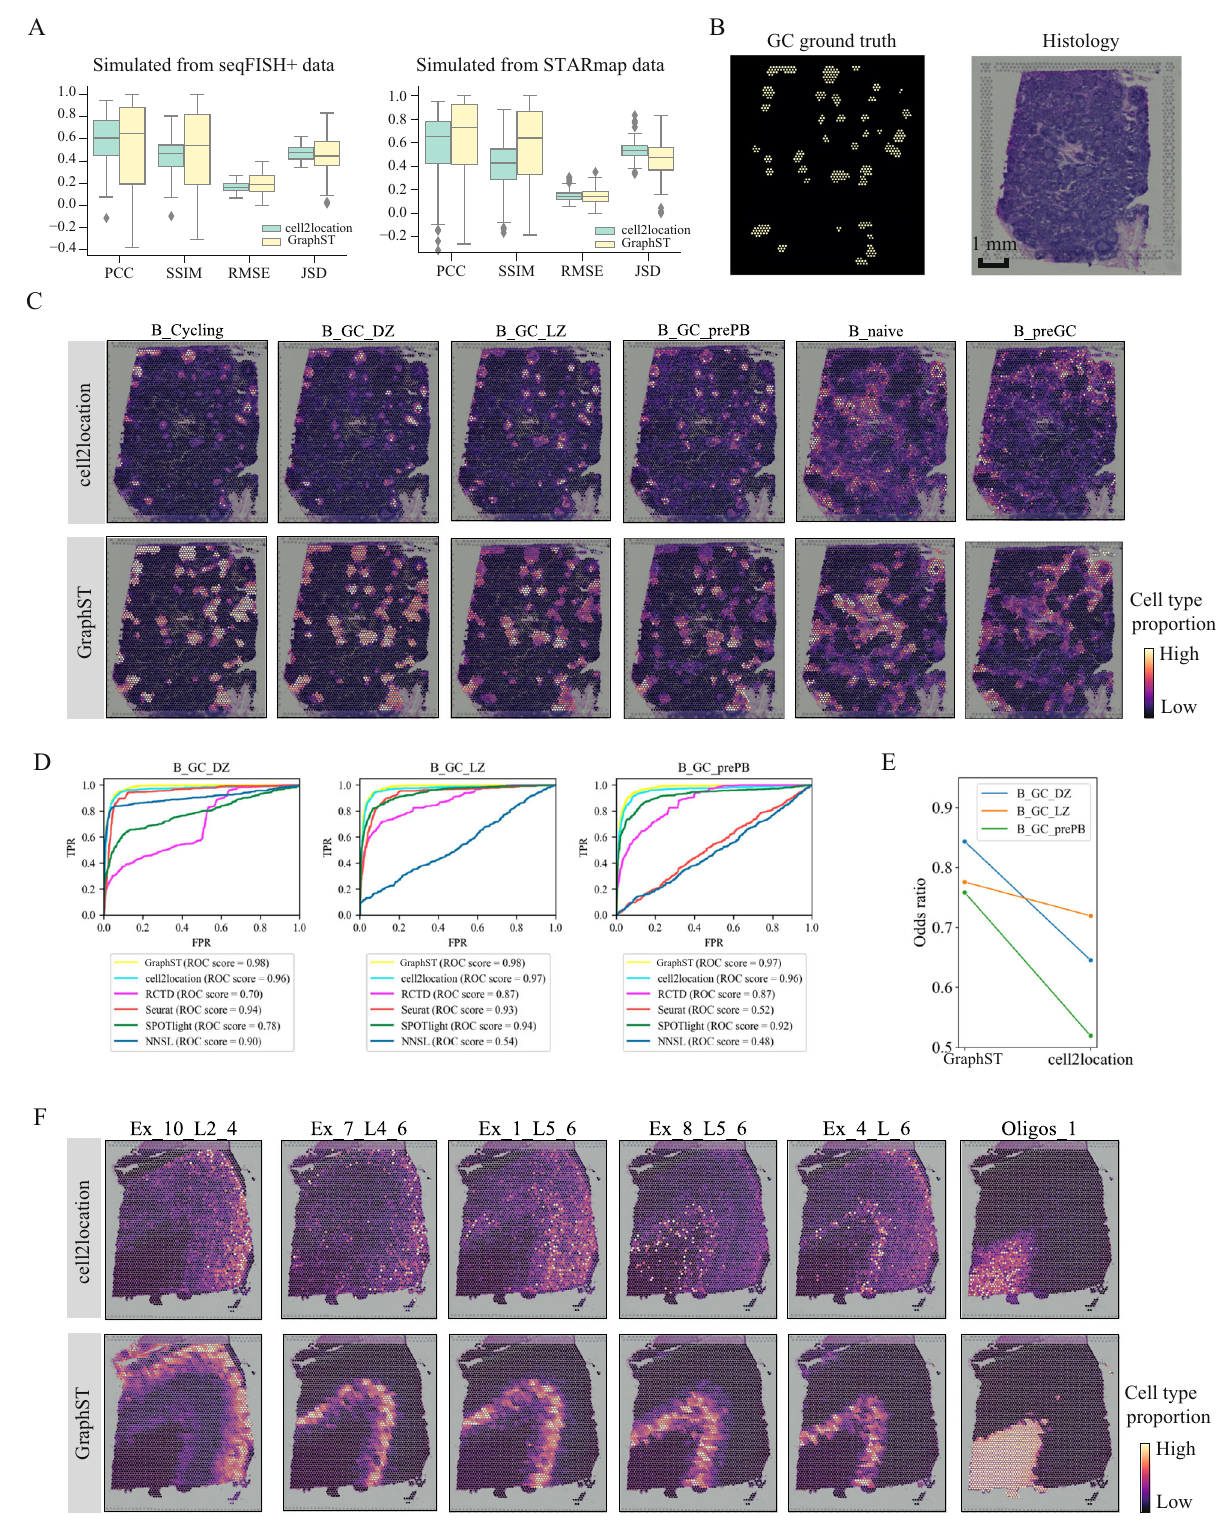
Accurate spatial mapping of cells to human breast cancer 10x Visium data revealed T-cell suppression in IDC regions In this comparison, we fi rst performed clustering on a human breast cancer 10x Visium dataset with 3798 spots and 36,601 genes. The data weremanuallyannotatedbyapathologistbasedontheH&Eimageand the spatial expression of reported breast cancer marker genes (Sup- plementary Figs. S12A and S13). The data was annotated with 20